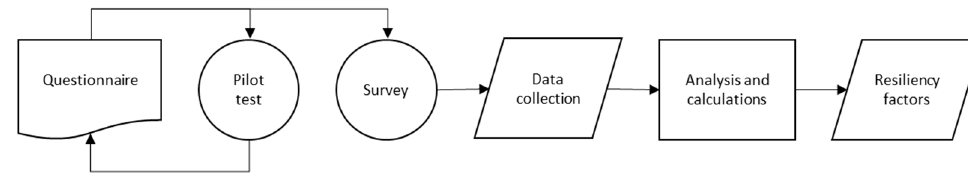
Figure 1. Schematic description of survey methodology.